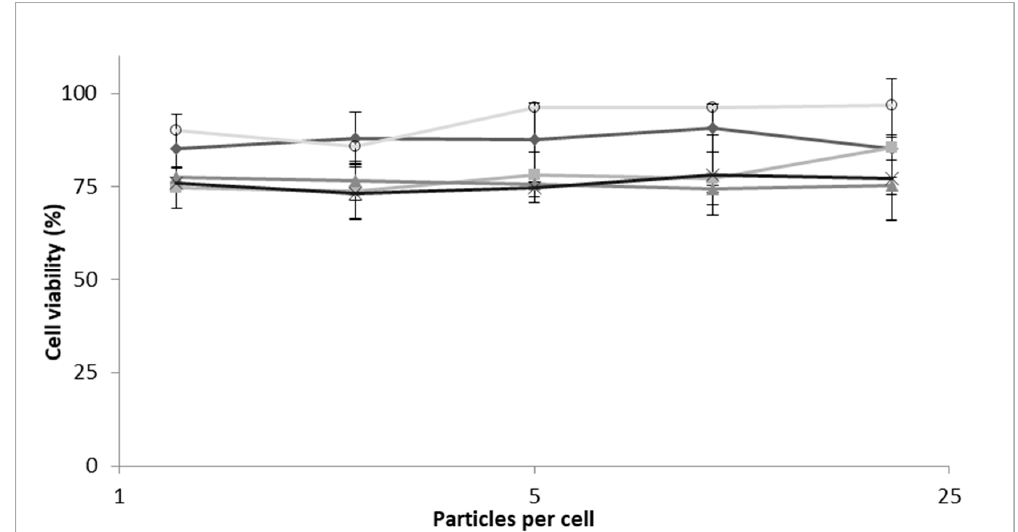
Figure 9. Cytotoxicity of particles with outer-layers composed of dextran ( ♦ ), heparin ( ■ ), poly (allylamine hydrochloride) ( ▲ ) and nonmodified conjugate cores (×) determined using the Alamar Blue Assay. Untreated cells were used as a control ( ○ ). The results are shown as the mean cell viability ± SD.